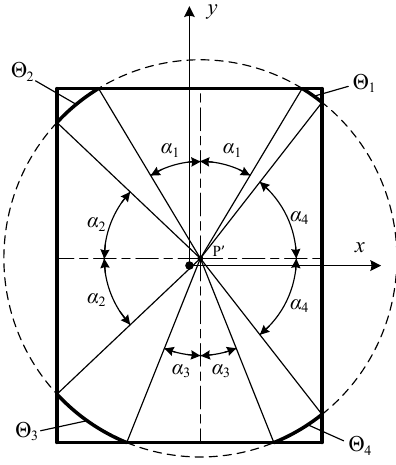
Figure 4. Illustration of the sub-rectangles divided from the projection point P ′ and the aperture. The final central angle summation can be expressed as the sum of central angles created by intersection of the projection circle and each